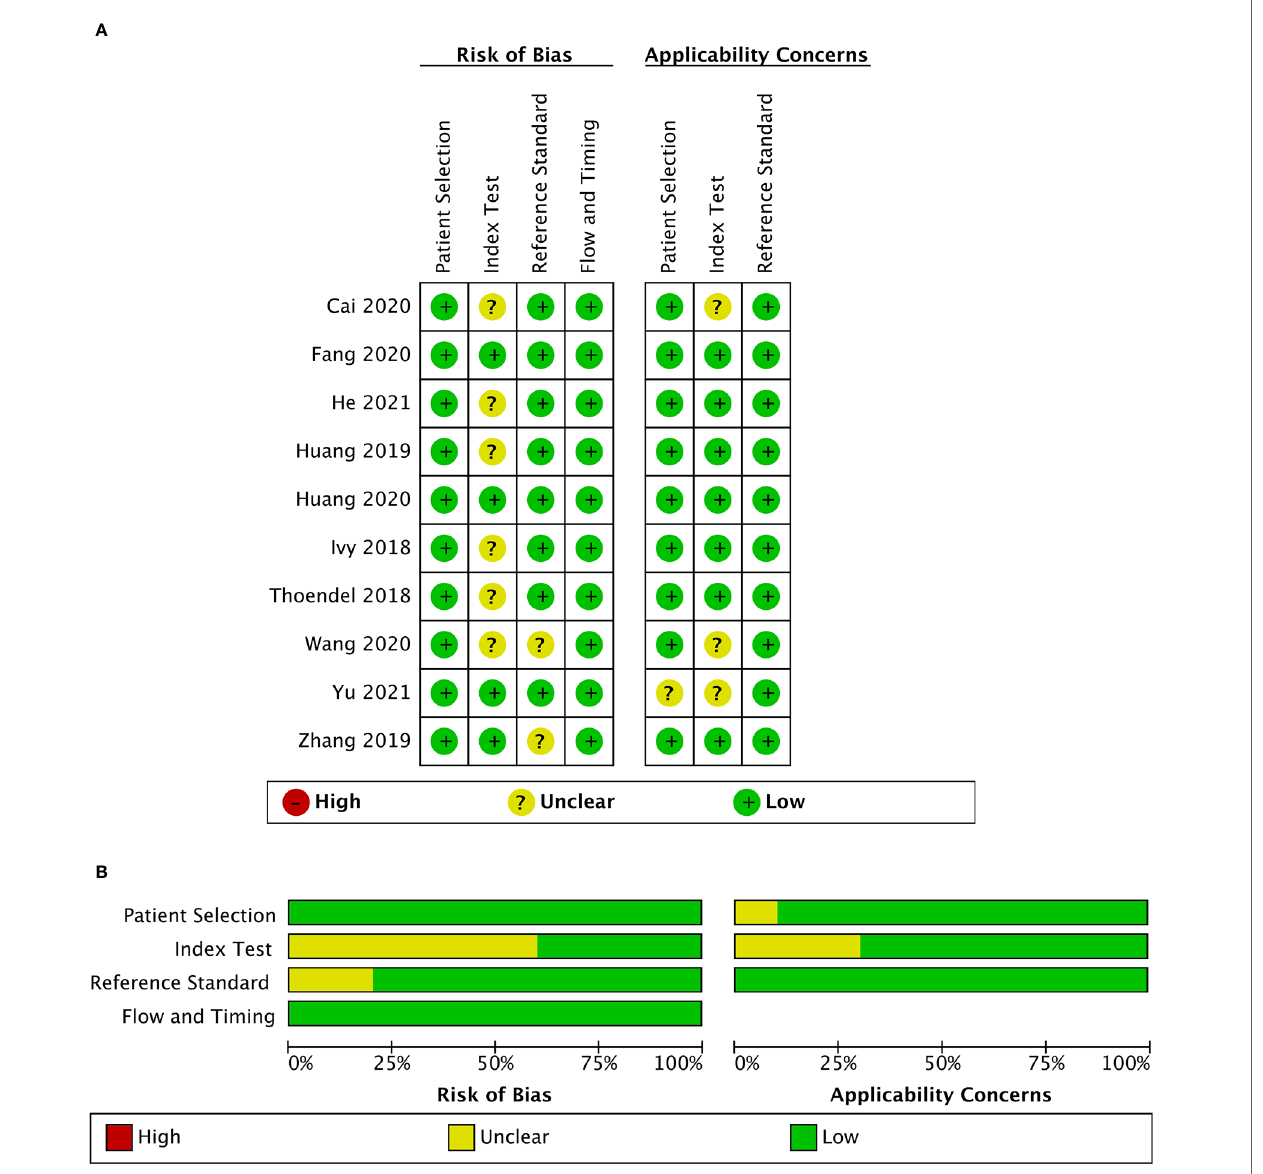
FIGURE 2 | Risk of bias and applicability concerns summary (A) ; risk of bias and applicability concerns graph (B)